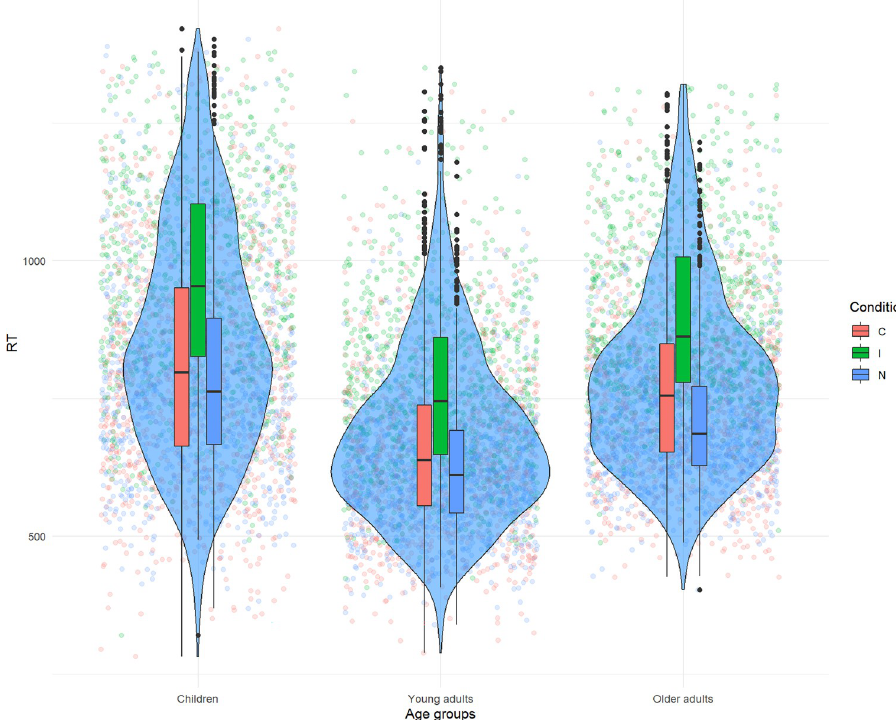
Fig 1. Distribution of the latencies per conditions and age groups. main effect of condition on reaction times (F(2,18.9) = 111.68; p < 0.001), a significant main effect of age groups (F(2,50) = 10.74; p < 0.001), and a significant interaction between the two (F(4, 8900.7) = 13.56; p < 0.001). The decomposition of the interaction reveals that children (t (132.6) = -8.83; p < 0.001), young (t(125.27) = -6.04; p < 0.001) and older adults (t(131.73) = -8.54; p < 0.001) show significantly increased latencies in the incongruent condition. As emphasized by the estimates of the model, the results show a modulation of the effect’s magni- tude among conditions and age groups, suggesting that the interference effect is the strongest for children (estimate = 104.96), while it is the weakest among the young adults group (esti- mate = 35.98), and intermediate for older adults (estimate = 94.86). Decomposition of the main effect of groups revealed that children (t(50) = 4.58; p < 0.001) and older adults (t(50) = -2.88; p = 0.016) had significantly lower latencies than young adults. Moreover, the group of children and older adults do not significantly differ (t(50) = 1.74; p = 0.201). Regarding accuracy, the results highlight a significant main effect of conditions ( χ 2 (2) = 162.44; p < 0.001), a significant main effect of age groups ( χ 2 (2) = 50.43; p < 0.001) but no inter- action between the two ( χ 2 (4) = 4.8; p = 0.3). The decomposition of the main effect of condi- tions suggests that congruent trials were less prone to errors than incongruent trials (Z = 6.68; p < 0.001), but none of the other comparisons reached significance. The age groups effect shows that accuracy was significantly lower in children compared to young adults (Z = -4.52; p < 0.001), however no significant differences were observed between children and older adults (Z = -0.02; p � 1) nor between young and older adults (Z = -0.02; p � 1).